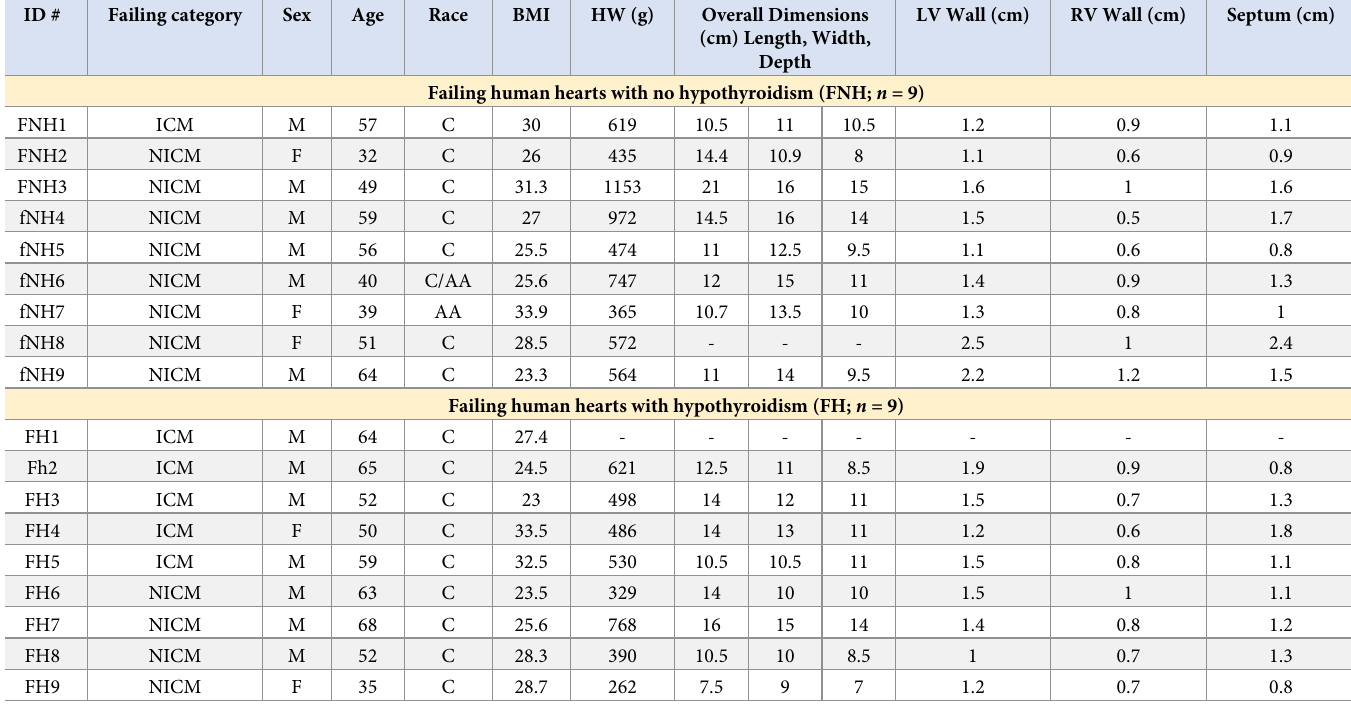
Table 2. HF patient demographics and characteristics of procured human hearts ( n =